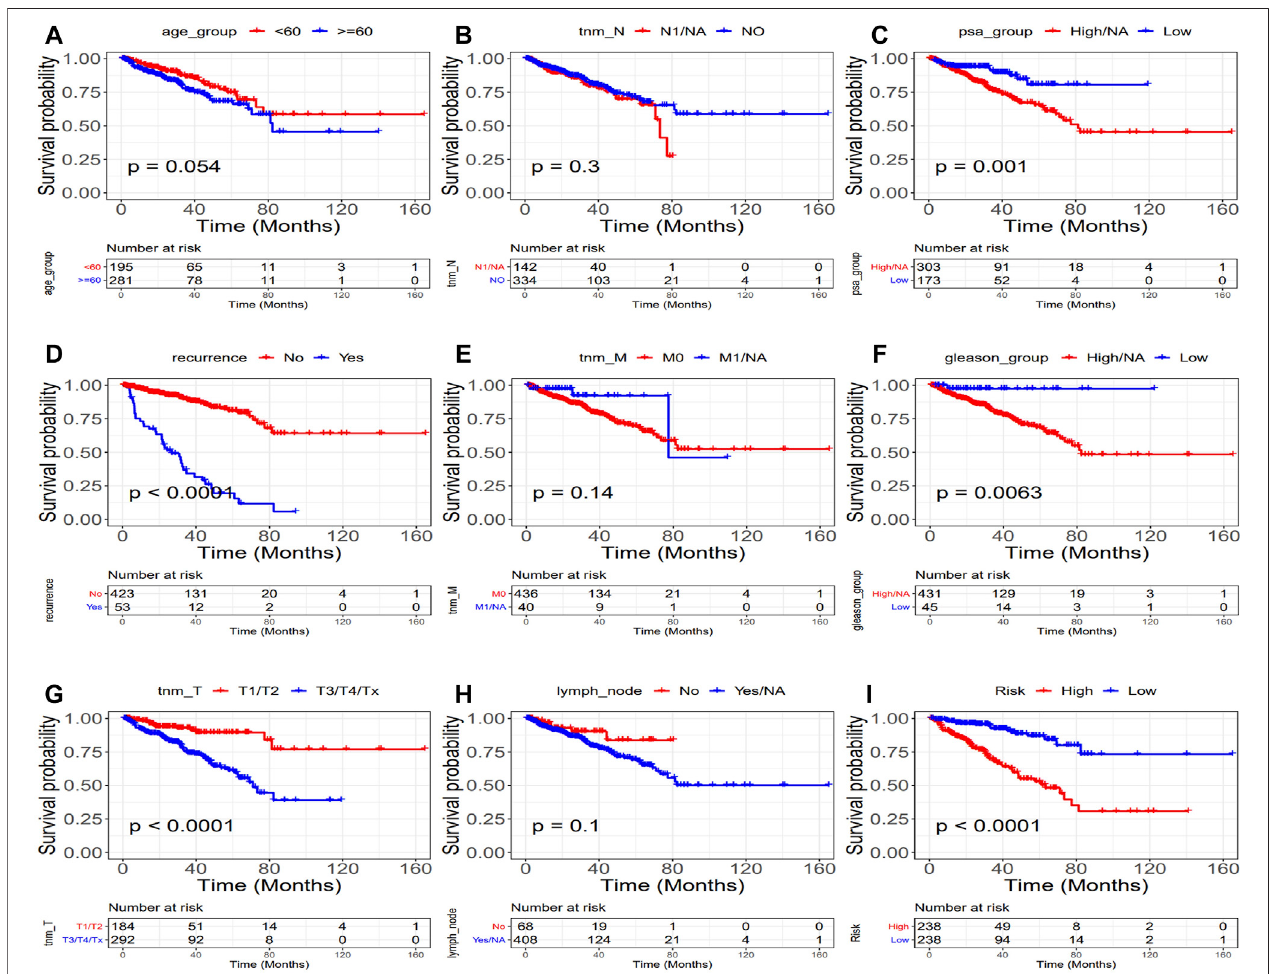
FIGURE7| Relationship betweenclinicalcharacteristics and prognosis(TCGA: PRAD).(Upperpartof fi gure:Patient ’ ssurvivalprobabilitybetweendifferentclinical features group at different times; Vertical axis: Survival probability; Horizontal axis: Time; lower part of fi gure: Number of cases in different groups at different Times.). (A) Age, (B) tnm-N, (C) PSA, (D) Recurrence, (E) tnm-M, (F) Gleason, (G) tnm-T (H) Lymph node, and (I) Risk. ( p = 0.0054, p = 0.3, p = 0.001, p < 0.0001, p = 0.014, p = 0.0063, p < 0.0001, p = 0.1, and p < 0.0001,